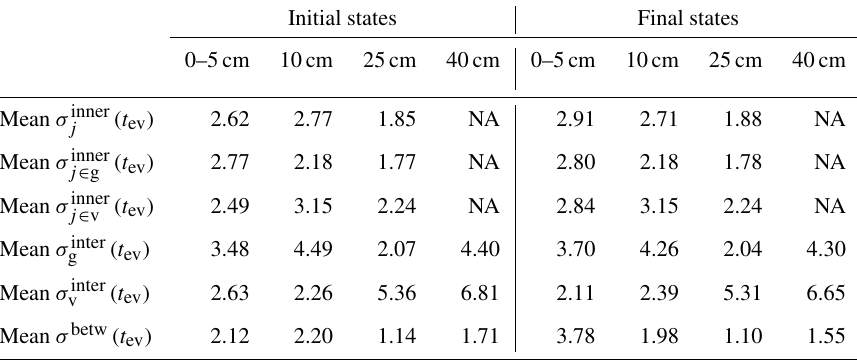
Table 2. Spatial variability of soil moisture at the plot scale (mean of all events calculated for all plots: mean σ inner (t ev ) ; and the vineyard plots: mean σ inner (t ev ) calculated with Eq. 6 in Table 1) and at the catchment scale (mean interplot plots: mean σ inner j ∈ g j ∈ v variability of the grassland plots: mean σ inter g (t ev ) , and the vineyard plots: mean σ inter v (t ev ) , calculated with Eq. 8 in Table 1 as well as between land use class variability mean σ betw . (t ev ) , calculated with Eq. 7 in Table 1) determined at different depth with the two measuring